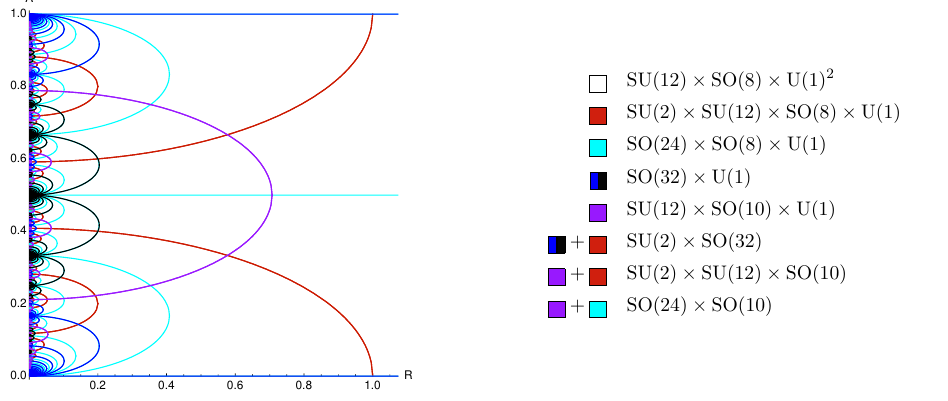
Figure 19. SO(32) heterotic with Wilson line A I = (( A ) 12 ; 0 4